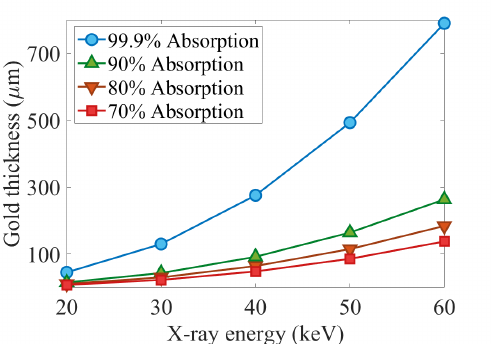
Figure 2. Required mask thickness (thickness of absorption part, which is gold here) to stop the X-ray